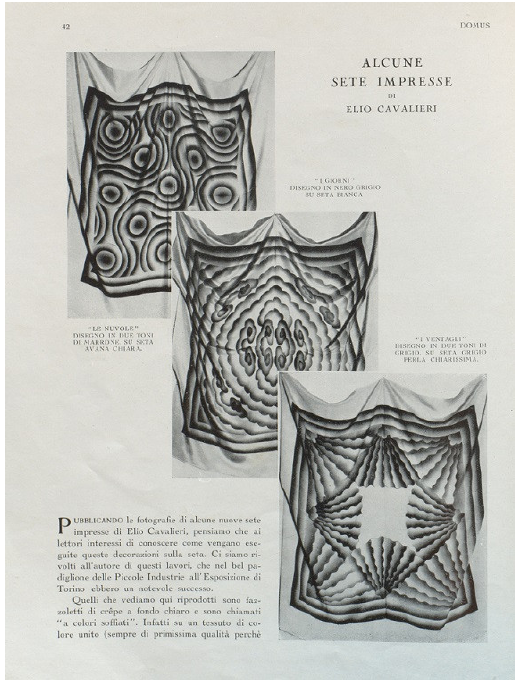
Figure 6. Some silk fabrics printed by Elio Cavalieri. Photo from (Ponti Vimercati 1929). In public domain.